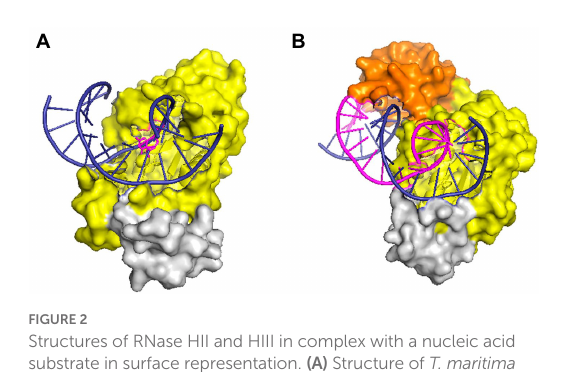
FIGURE 2 Structures of RNase HII and HIII in complex with a nucleic acid substrate in surface representation. (A) Structure of T. maritima RNase HII complexed with a dsDNA containing a single ribonucleotide [protein data bank (PDB) code 3O3F]. (B) Structure of the complex between Thermovibrio ammonificans RNase HIII and an RNA/DNA hybrid (PDB code 4PY5). In both panels, the “RNase H-fold” structure is shown in yellow, the C-terminal helix domain is colored gray, and the N-domain of RNase HIII is shown in orange. Nucleic acid substrates are shown in cartoon representation with DNA strands in deep blue and RNA in purple. The figure was prepared using